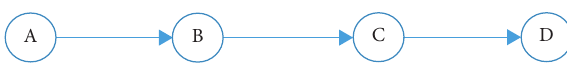
Figure 1: Railway physical network.